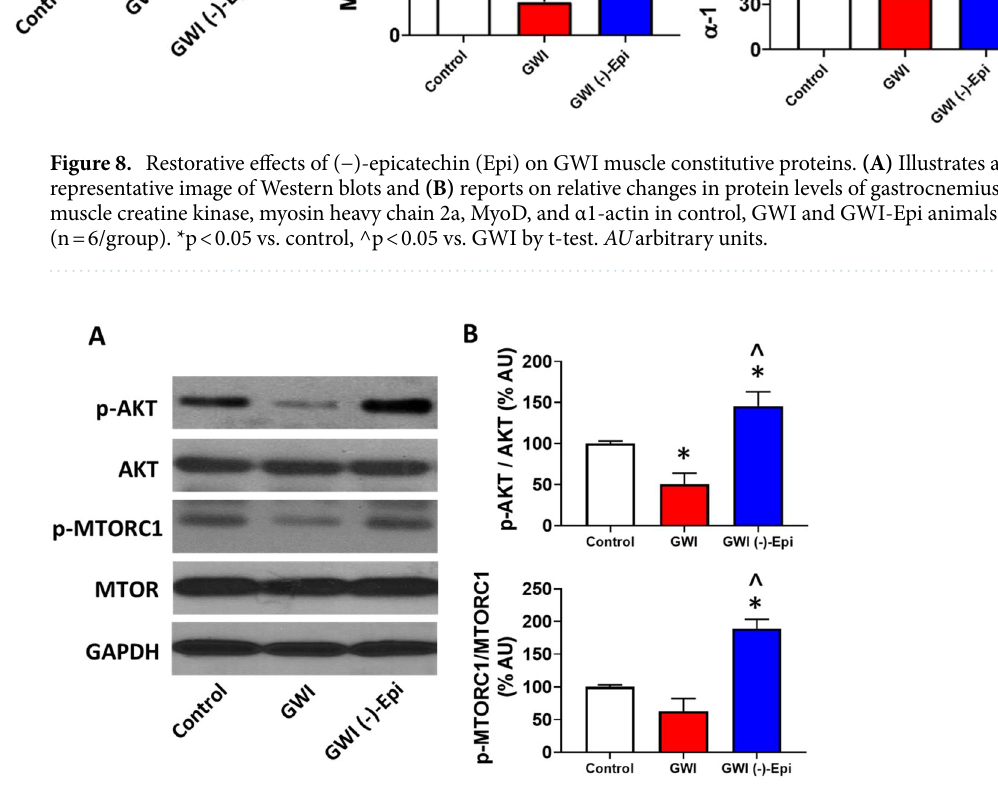
Figure 9. Effects of (−)-epicatechin (Epi) on GWI muscle activation of AKT and MTORC1, two major components of the protein synthesis pathway. ( A ) Illustrates a representative image of Western blots of AKT phosphorylation at Ser473 and MTORC1 at Ser2448 (activation sites); ( B ) reports on phosphorylation activation relative changes in protein levels of gastrocnemius muscle p-AKT and p-MTORC1 in control, GWI and GWI-Epi animals (n = 6/group). *p < 0.05 vs. control, ^p < 0.05 vs. GWI by t-test. AU arbitrary